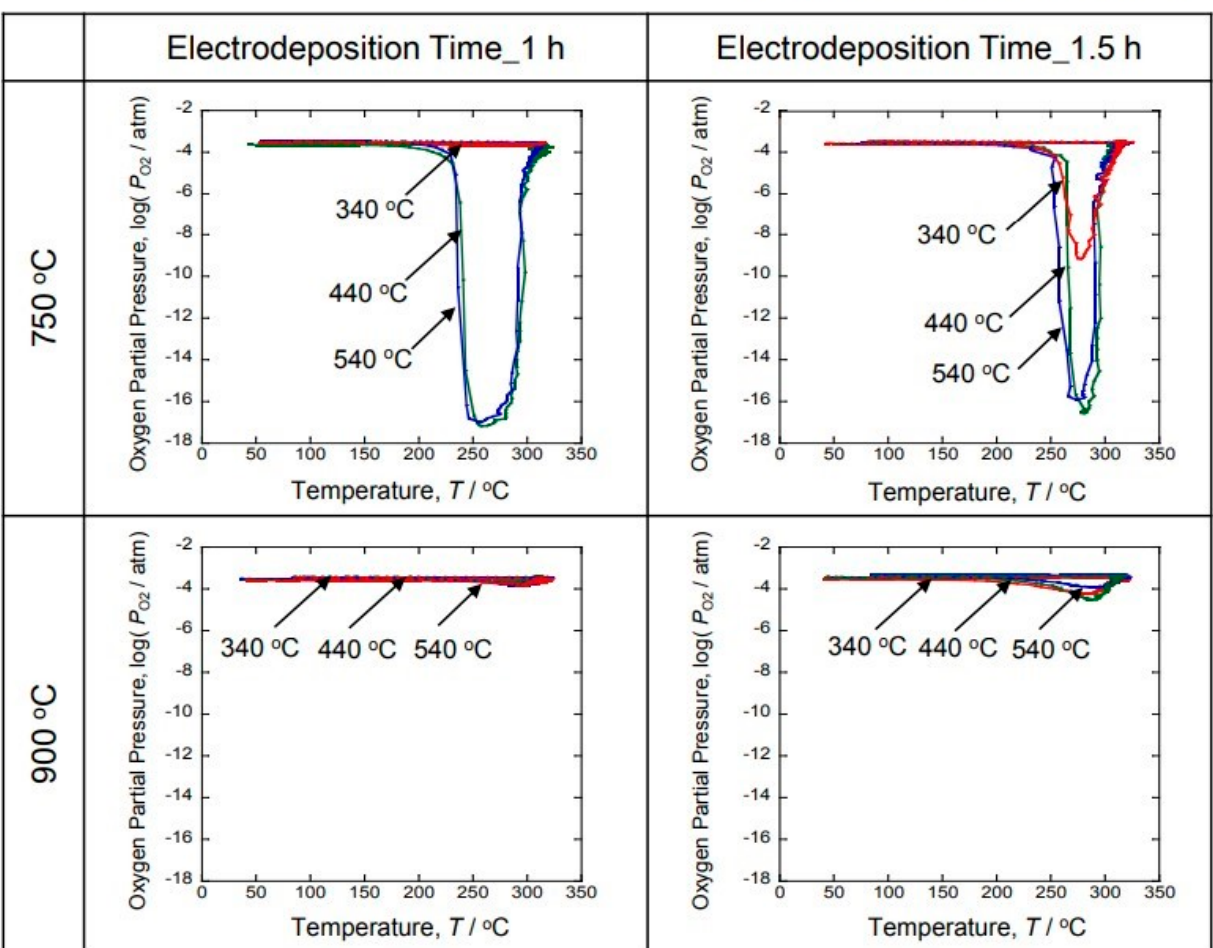
Figure 8. Oxygen partial pressure–temperature curves of Ni after La deposition at − 2.25 V in NaCl-KCl-5.0 mol%LaF 3 melts at 750 °C and 900 °C. (Hydrogen storage temperature: 340 °C, 440 °C and 540 °C.)